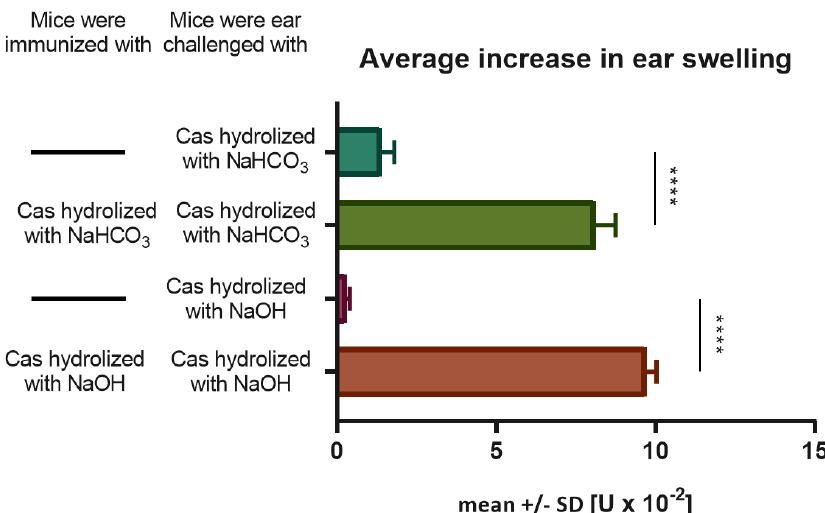
Figure 1. Immunogenicity of soluble casein (Cas) antigen obtained by alkaline hydrolysis with either NaHCO 3 or NaOH. Mice had been intradermally (id) immunized with a saline solution of soluble Cas antigen (100 µ g per mouse) 5 days before challenging by id administration of the same Cas solution (5 µ g per earlobe). Twenty-four hours later ear swelling response was measured and expressed as mean ± SD [units (U) × 10 − 2 mm] (n = 4, N = 3). **** p < 0.0001.